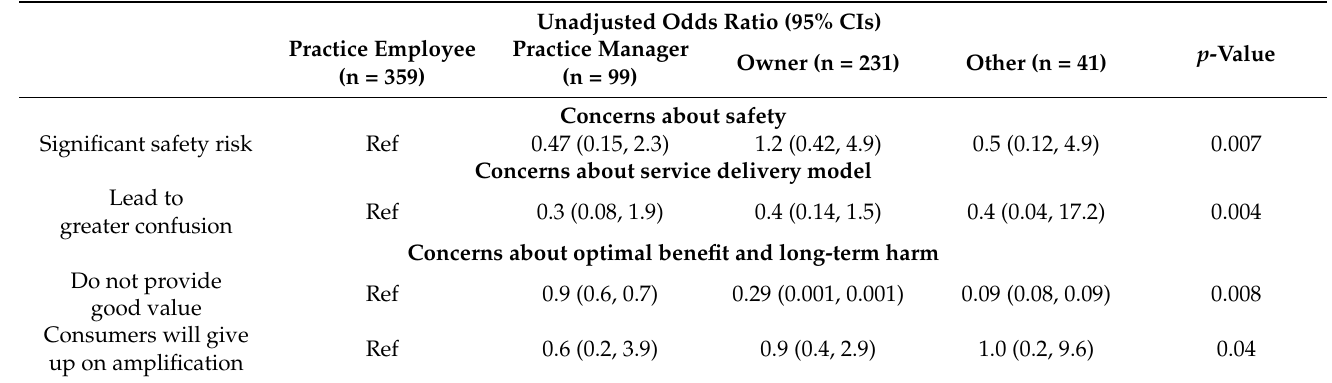
Table 4. Relationship between hearing healthcare professionals’ (HHPs) primary position and the views on over-the-counter (OTC) hearing